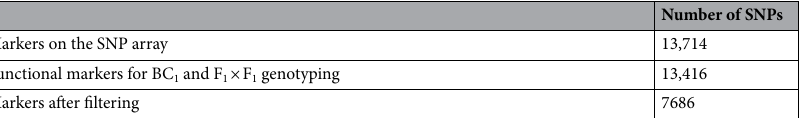
Table 2. Results from genotyping BC 1 and F 1 × F 1 populations with the 15 K Illumina Infinium SNP array. Functional markers are the markers without missing SNP data. SNP information filtering was done for a minor allele frequency of